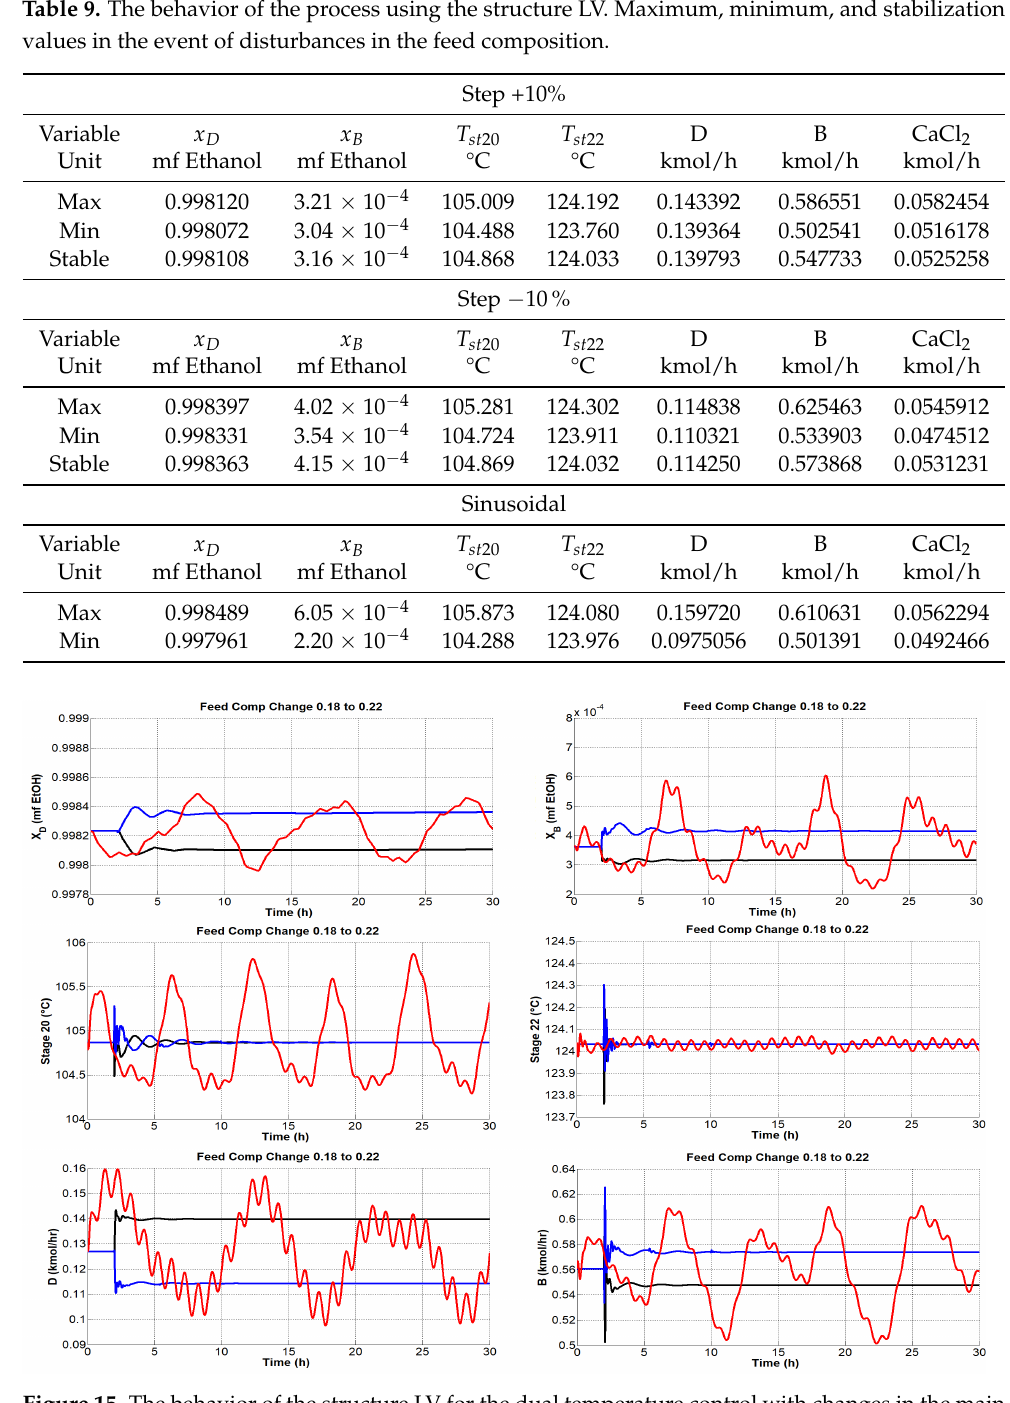
Figure 15. The behavior of the structure LV for the dual temperature control with changes in the main feed in a stepwise form of 10% mf ( black ) and − 10% mf ( blue ), also the sinusoidal changes in the mole fraction ( red